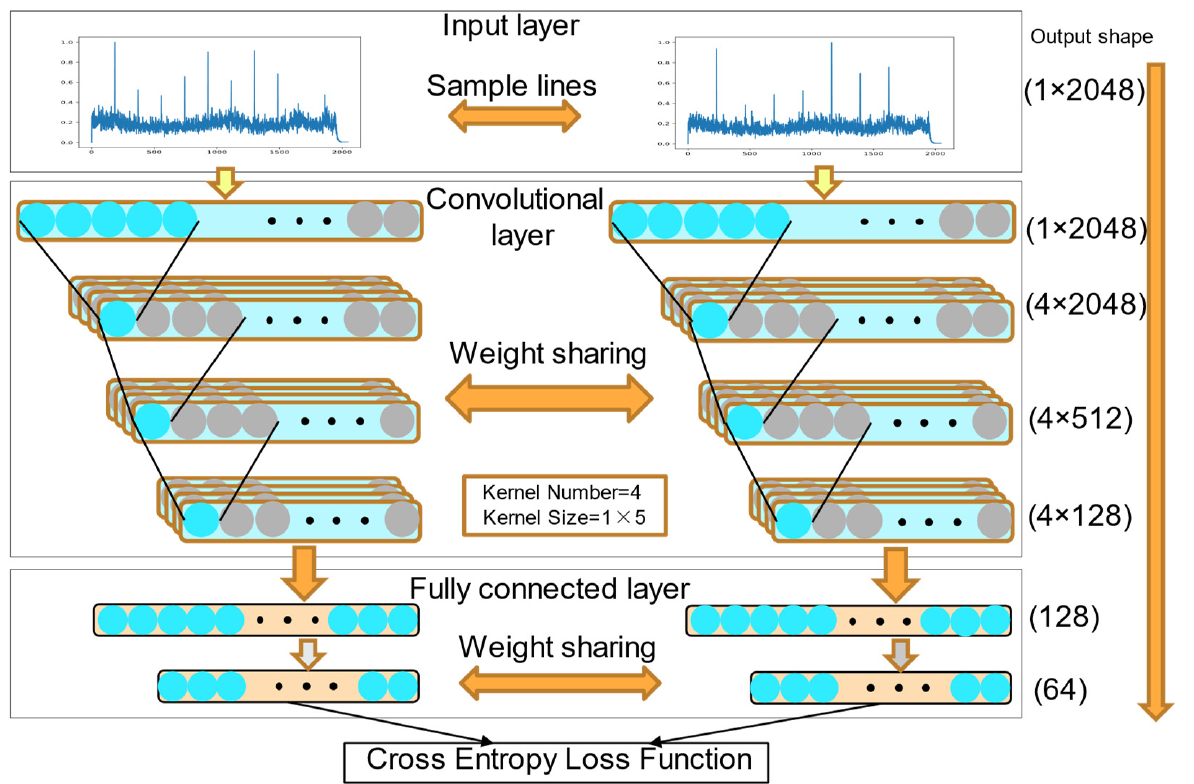
Figure 4. The proposed Siamese network architecture.